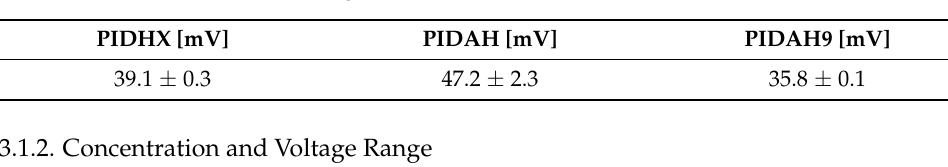
Table 3. Tested sensors blank voltage values.